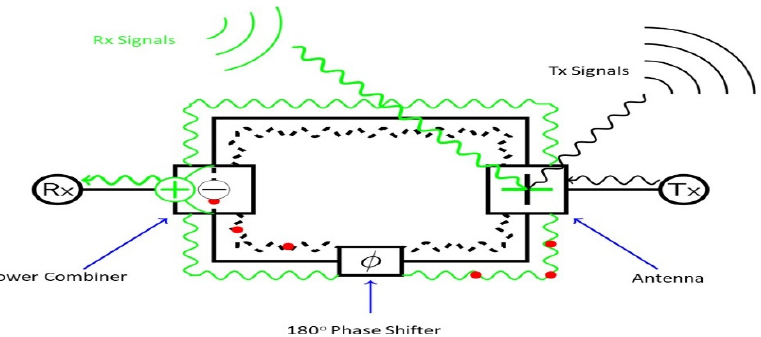
Figure 10. Proposed SIW antenna system operation (red dot represent the out-of-phase component) [21]. A stacked microstrip patch antenna array with SIW feeding structure is used for wideband application. In [22], an antenna element with linear polarization and wide bandwidth of 83.75 from (50–74) GHz with 8.7 dBi value of average gain is demonstrated. In [22,37,38,41–44], with different strategies, the SIW techniques have been used and effective results in terms of gain, bandwidth, and efficiency were achieved. Advantages and disadvantages of different techniques are shown in Table